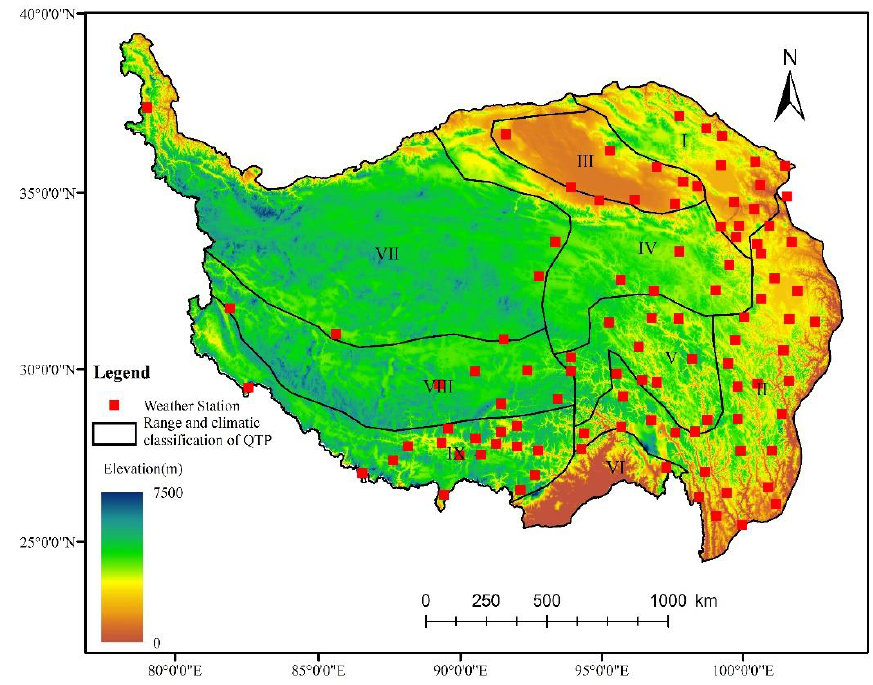
Figure 1. Elevation and the location of nine secondary climate systems of QTP.